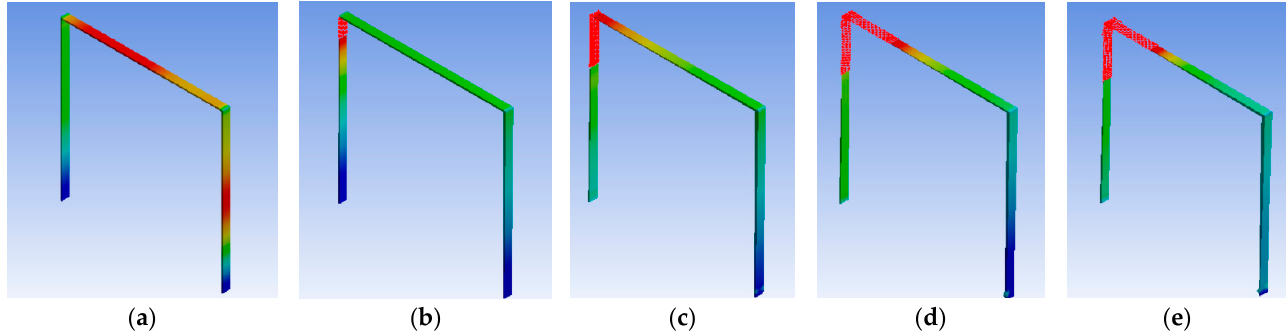
Figure 17. Stress concentration on the seismic joint for different levels of horizontal displacement for B2 frame with 11 dbL lap-splice length: ( a ) 0.5 mm, ( b ) 23 mm, ( c ) 42 mm, ( d ) 53.7 mm, ( e ) 81.4 mm.